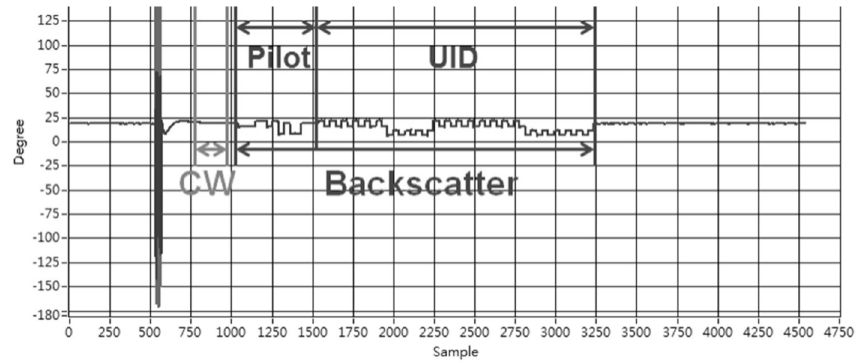
Figure 4. MIMO tag backscatter signal format.